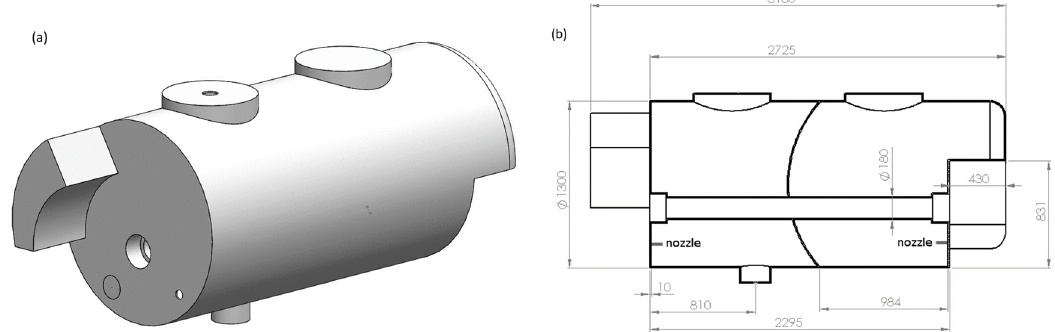
Figure 1. Geometry of the sprayer tank with a 3000 L of capacity. ( a ) Exterior 3-dimensional (D) view; ( b ) Internal longitudinal section, 2D view, with two interconnected parts. Dimensions in millimetres.